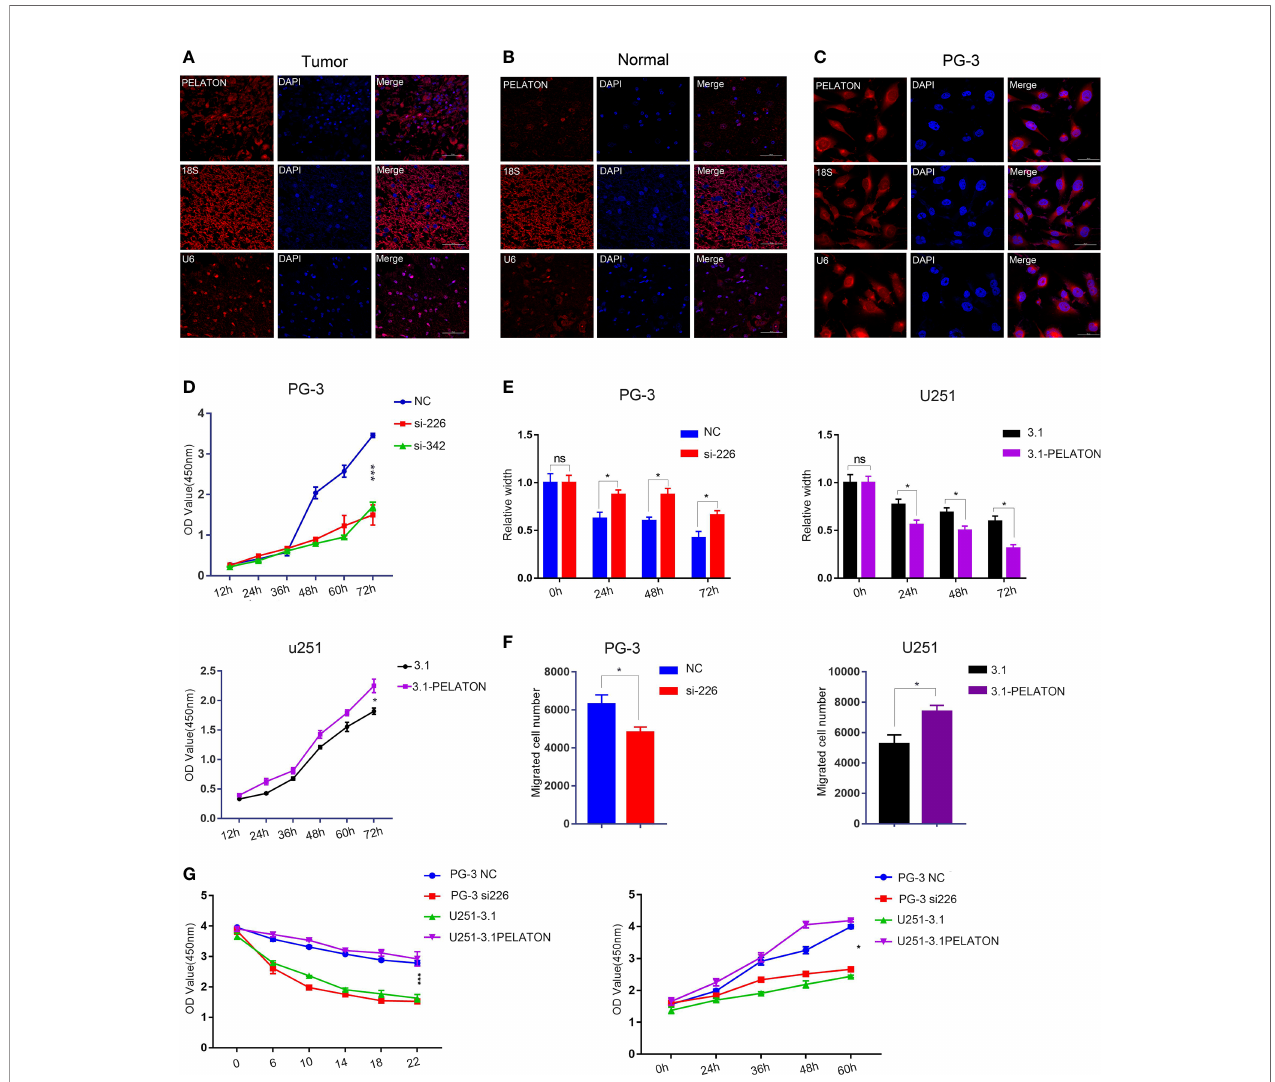
FIGURE 5 | PELATON promotes GBM cell phenotypes. Fluorescence in situ hybridization of PELATON in GBM tissues (A) , normal brain tissues (B) , and GBM cells (C) . (D) CCK8 analysis of PELATON knockdown or overexpression on glioblastoma cell proliferation (*p < 0.05; ***p < 0.001), independent experiment was repeated for three times. (E) Quanti fi cation of the migration ability of PG-3 (left) and U251 (right) cells after interference or overexpression with PELATON (*p < 0.05; ns, not signi fi cant), Datas were mean ± SEM for three independent experiments. (F) Quanti fi cation of the number of invasive cells after knockdown (left) or overexpression (right) of PELATON in glioblastoma cells (*p< 0.05), Datas were mean ± SEM for three independent experiments. (G) CCK8 analysis of PELATON overexpression or knockdown on proliferation and sensitivity to the ferroptosis inducer erastin (*p< 0.05, ***p < 0.001), Datas were mean ± SEM for three independent